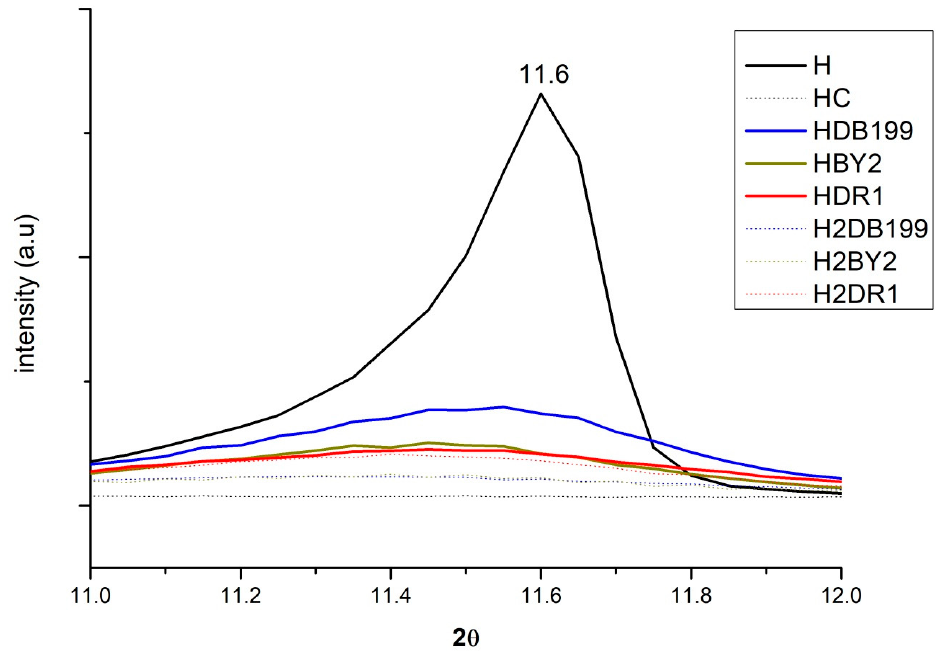
Figure 3. XRD for Hydrotalcite, Hydrotalcite calcinated at 600 °C for 4 h., samples HDB199, HBY2, HDR1, H2DB199, H2BY2 and H2DR1 in the range of 10° to 12.5°.